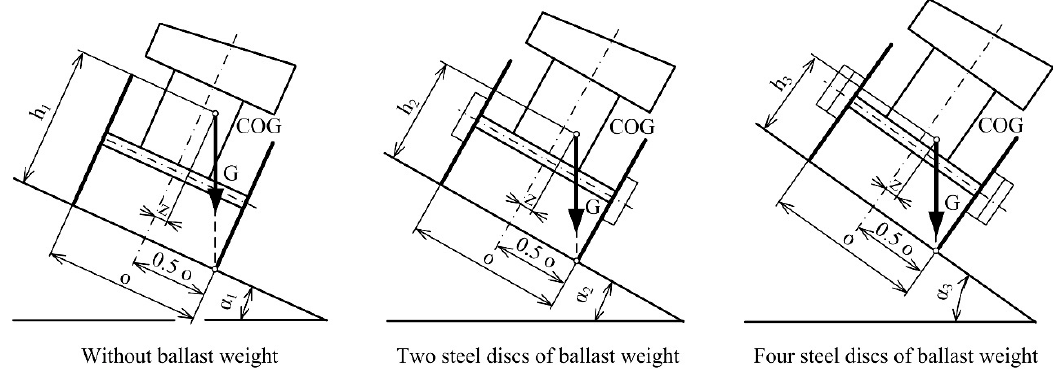
Figure 2. Influence of the rear wheel ballast weight on tractor stability: o —overall tire width; z —lateral position of COG; α —static overturning angle; h —vertical coordinate of COG.